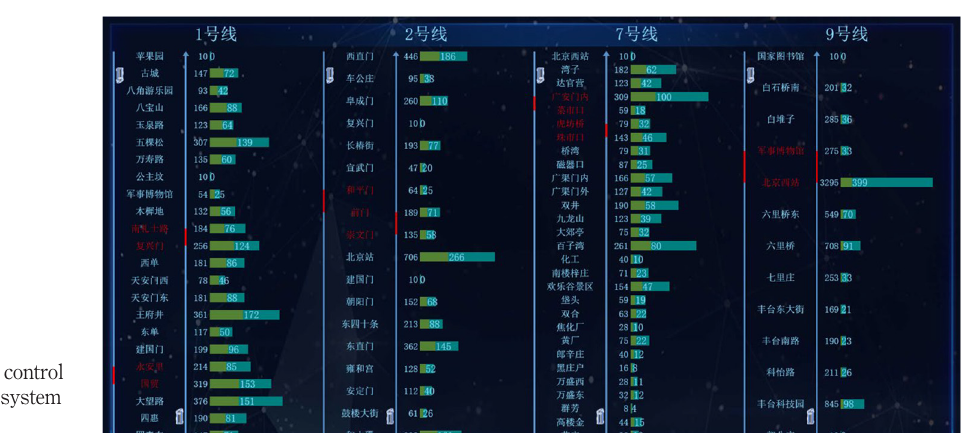
Figure 3. Digital fl ow control center-level system